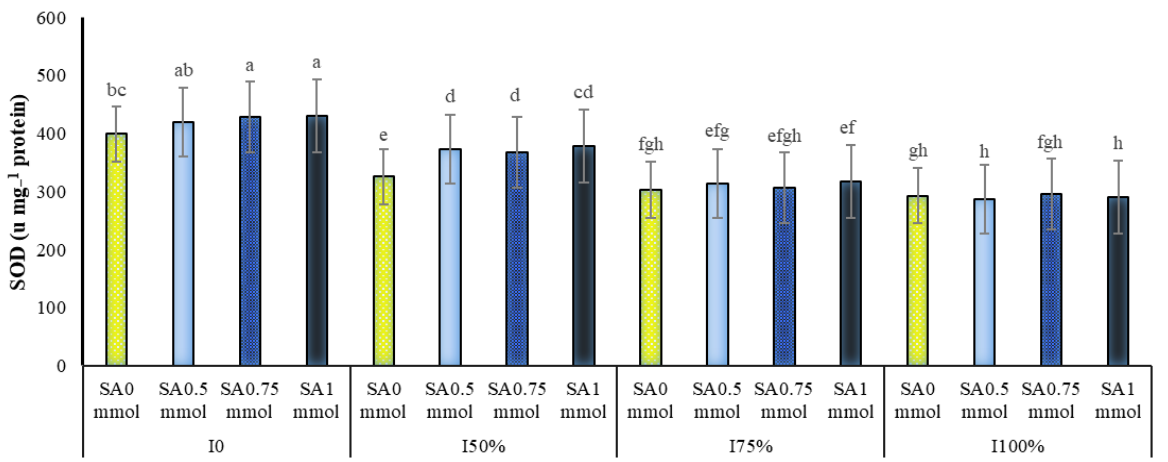
Figure 3. Dual interaction of different levels of irrigation (I0 = no irrigation, I50% = 50%, I75% = 75% and I100% = 100% water requirement of the plant) and salicylic acid application concentrations (SA0 = non-application, SA0.5 = 0.5 mmol, SA0.75 = 0.75 mmol and SA1 = 1 mmol) on the activity of superoxide dismutase (SOD) enzyme in A. hirtifolium . Columns designated by the same letter are not significantly different at the p ≤ 0.05 level as determined by the LSD test.